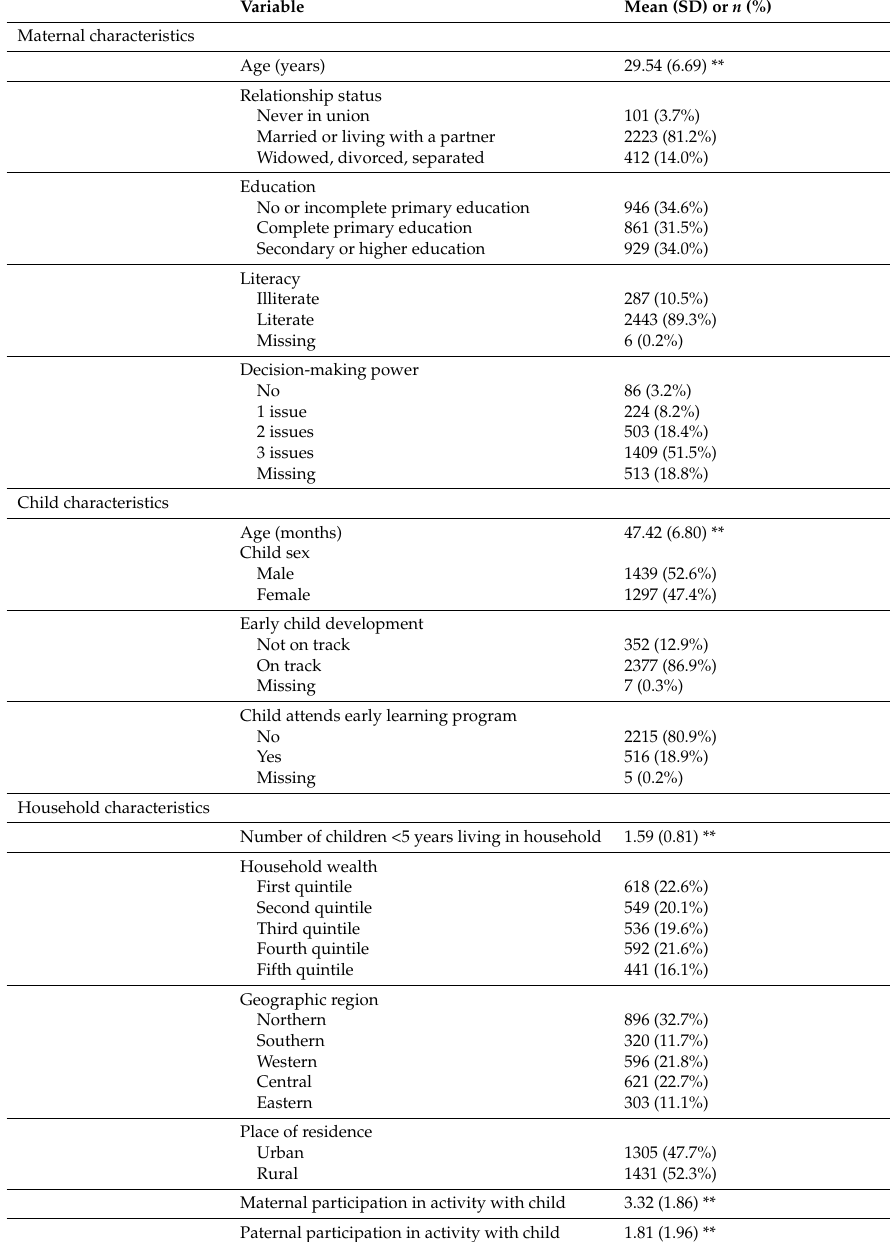
Table 1. Descriptivecharacteristicsofsample*, n =2736.